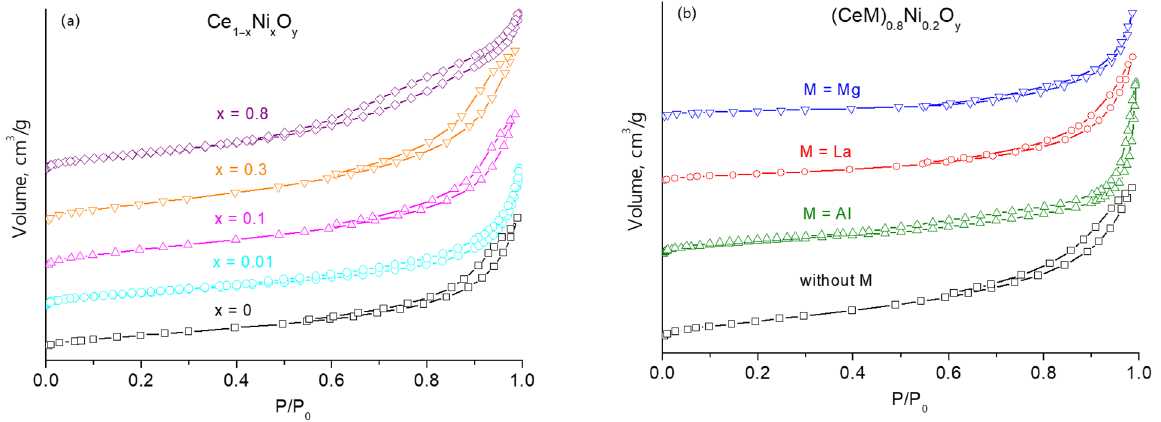
Figure 3. N 2 adsorption–desorption isotherms for (CeM) 1 − x Ni x O y (M = Al, La, Mg) samples: effect of Ni molar fraction ( a ) and M type ( b ). ( b )—M/Ce molar ratio is equal to 1. Isotherms are shifted relative to each other along the Y axis.